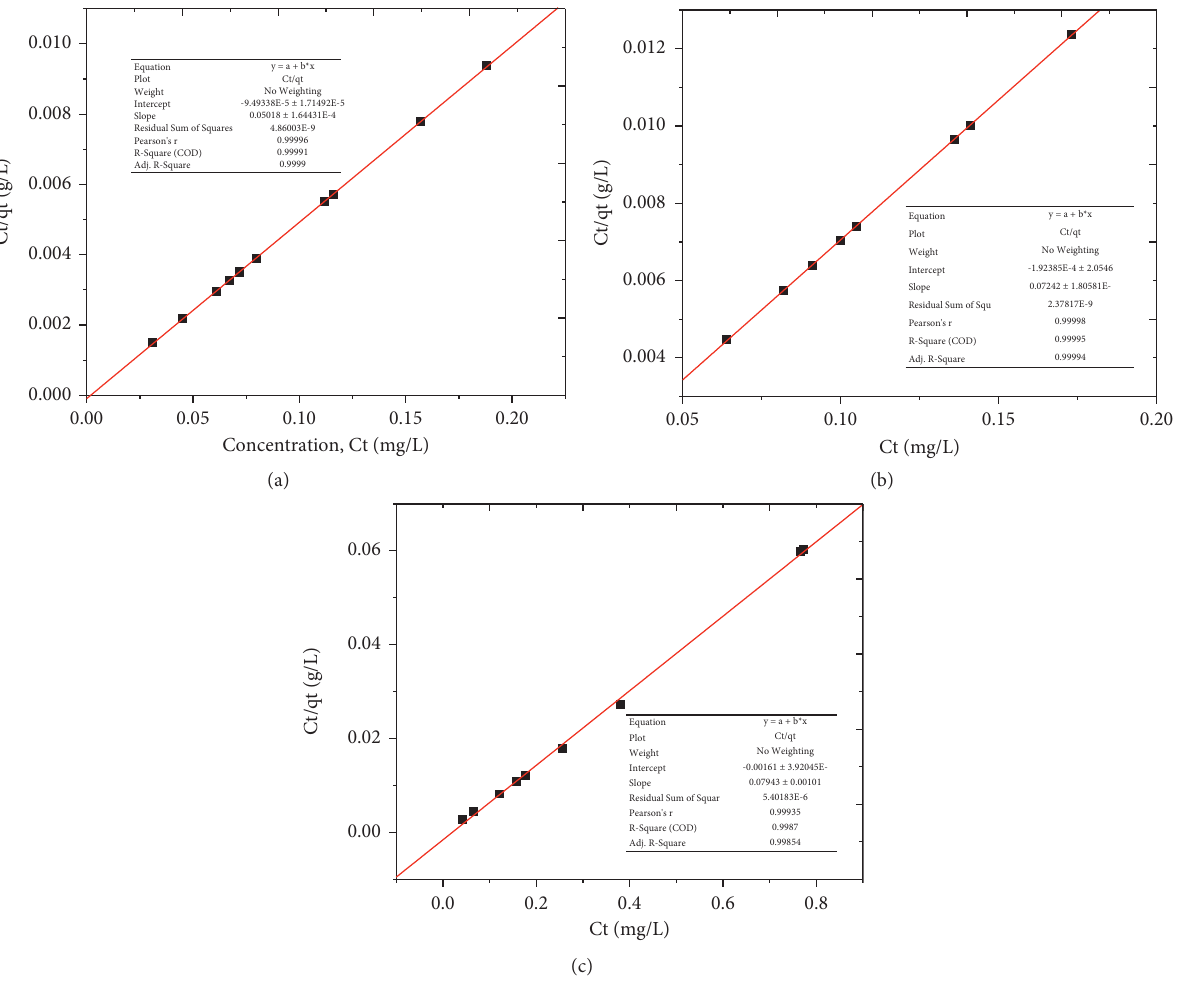
Figure 7: Langmuir isotherm model fit for (a) 24mg, (b) 34.5mg, and (c) 33mg combined mass HAP-BENT adsorbents.